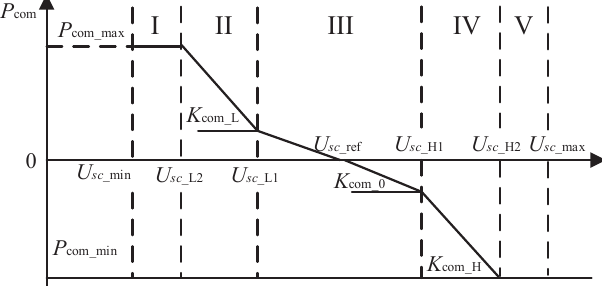
Figure 5. Diagram block of the SC module voltage adaptive control.